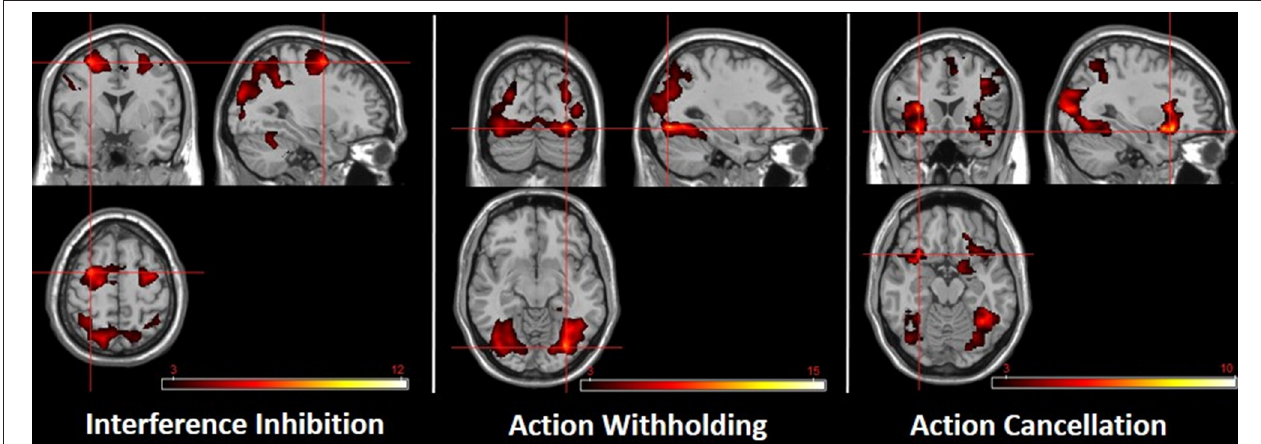
FIGURE 2 | Subcomponents of response inhibition in healthy controls. The crosshairs highlight the location of the highest t -value. Left: interference inhibition ( − 30, 0, 58). Middle: action withholding (30, − 78, − 10). Right: action cancellation ( − 32, 18, − 16). CDT of P < 0.01 ( k ≥ 452). The color bar indicates t-scores, with red to yellow indicating a positive